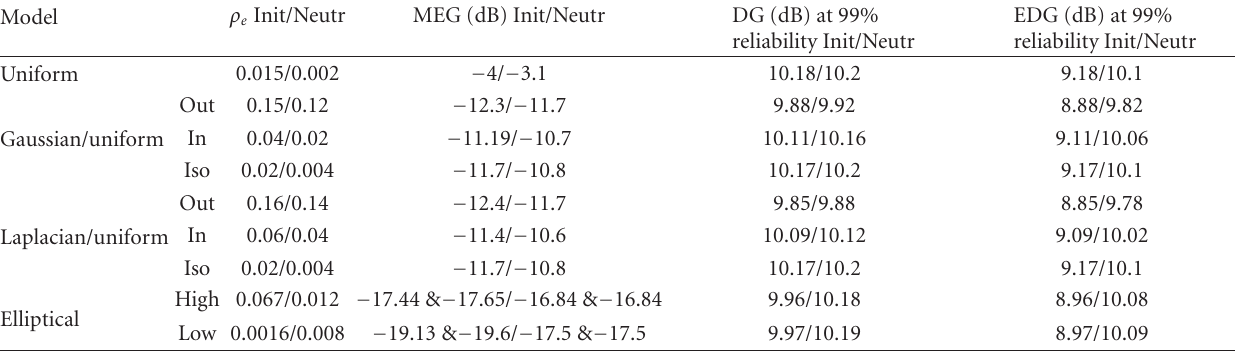
Table 2: Diversity performance of the two prototypes in di ff erent propagation environments at 2 GHz by using their simulated 3D radiation patterns.